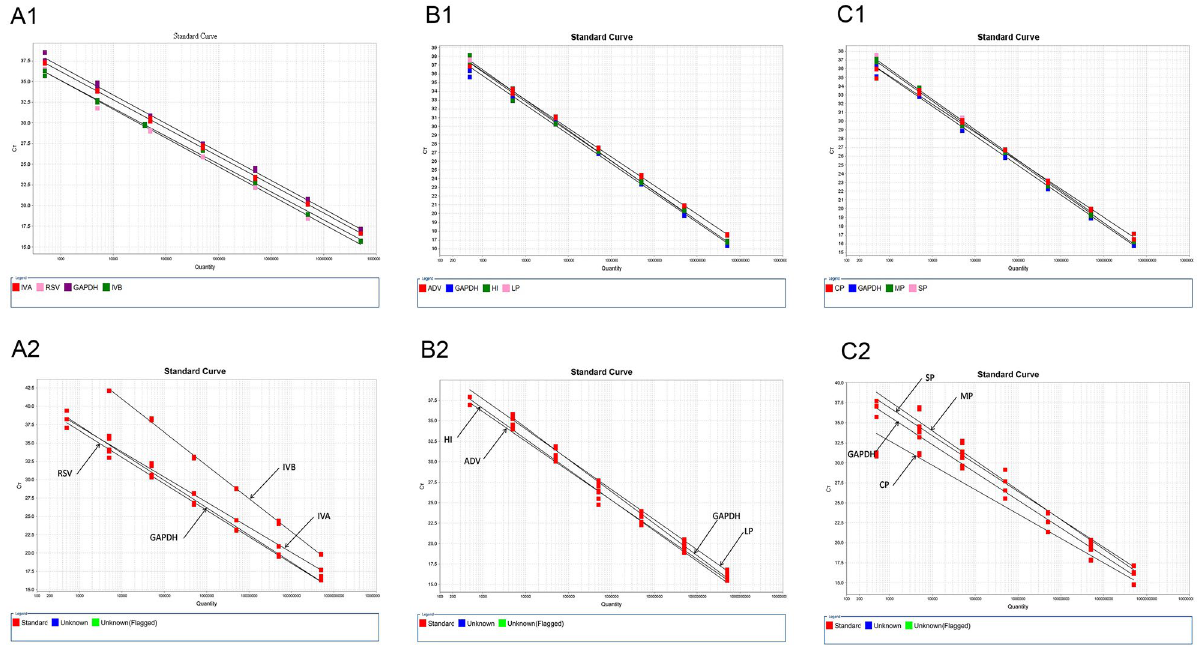
Figure 1. Standard curves of multiplex real-time PCR. A1, B1 and C1 are the standard curves conducted using single portions of each pathogenic nucleic acids, serial tenfold dilutions (5 × 10 8 to 5 × 10 2 copies/ml) by the four- plex real-time PCR assay in tubes A, B and C, respectively. A2, B2, and C2 are the standard curves generated under the condition of serial tenfold dilutions of the mixed nucleic acids (5 × 10 8 to 5 × 10 2 copies/ml) from all target pathogens by the multiplex real-time PCR assay in tubes A, B and C, respectively. R 2 E (%) Tube Target Single pathogen Multi pathogen Single pathogen Multi